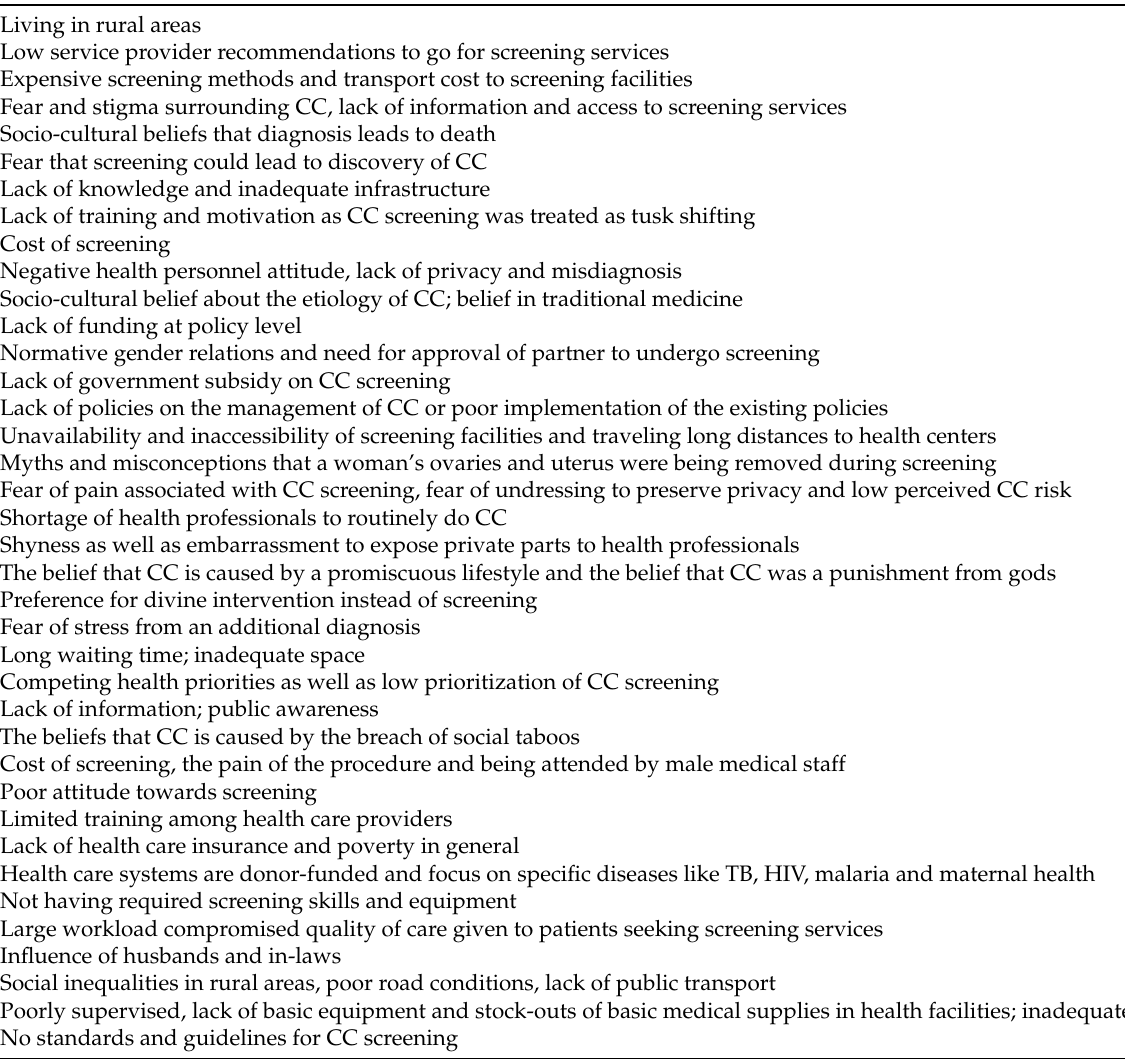
Table 3. Barriers to CC screening